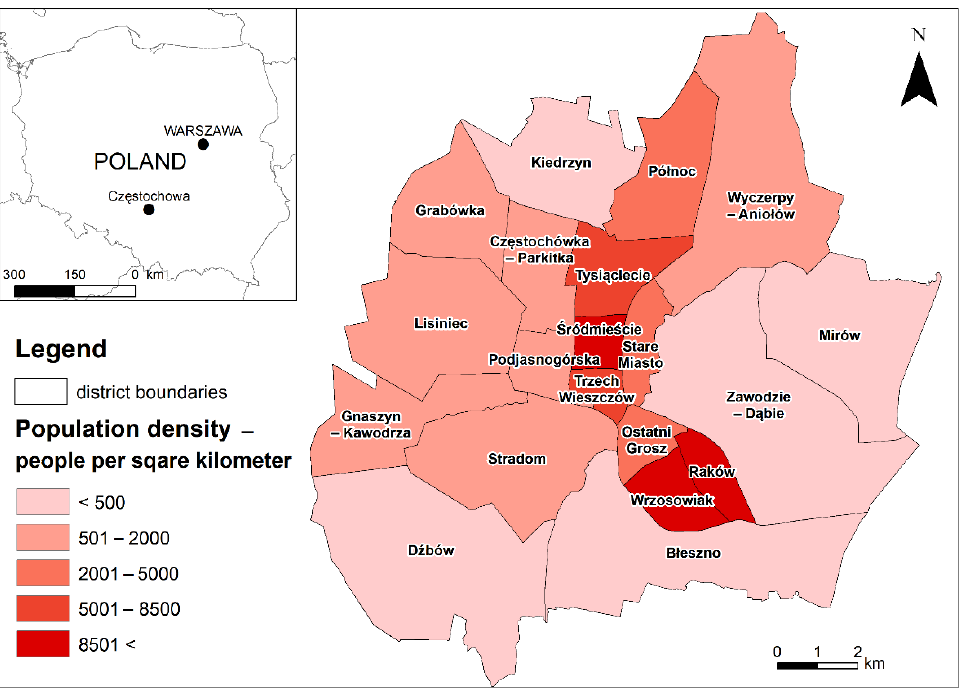
Figure 2. The location of Częstochowa in Poland, the division of the city into districts , and these districts’ population density (people per square kilometer). Source: Prepared by K. Kołat.